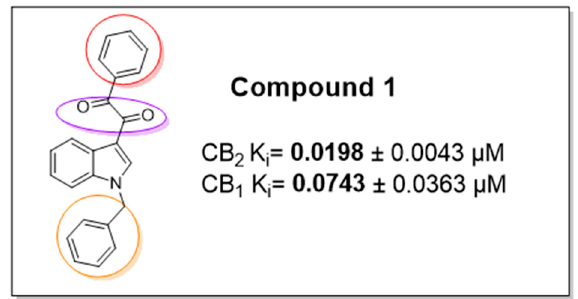
Figure 34. Structure of compound 1 .